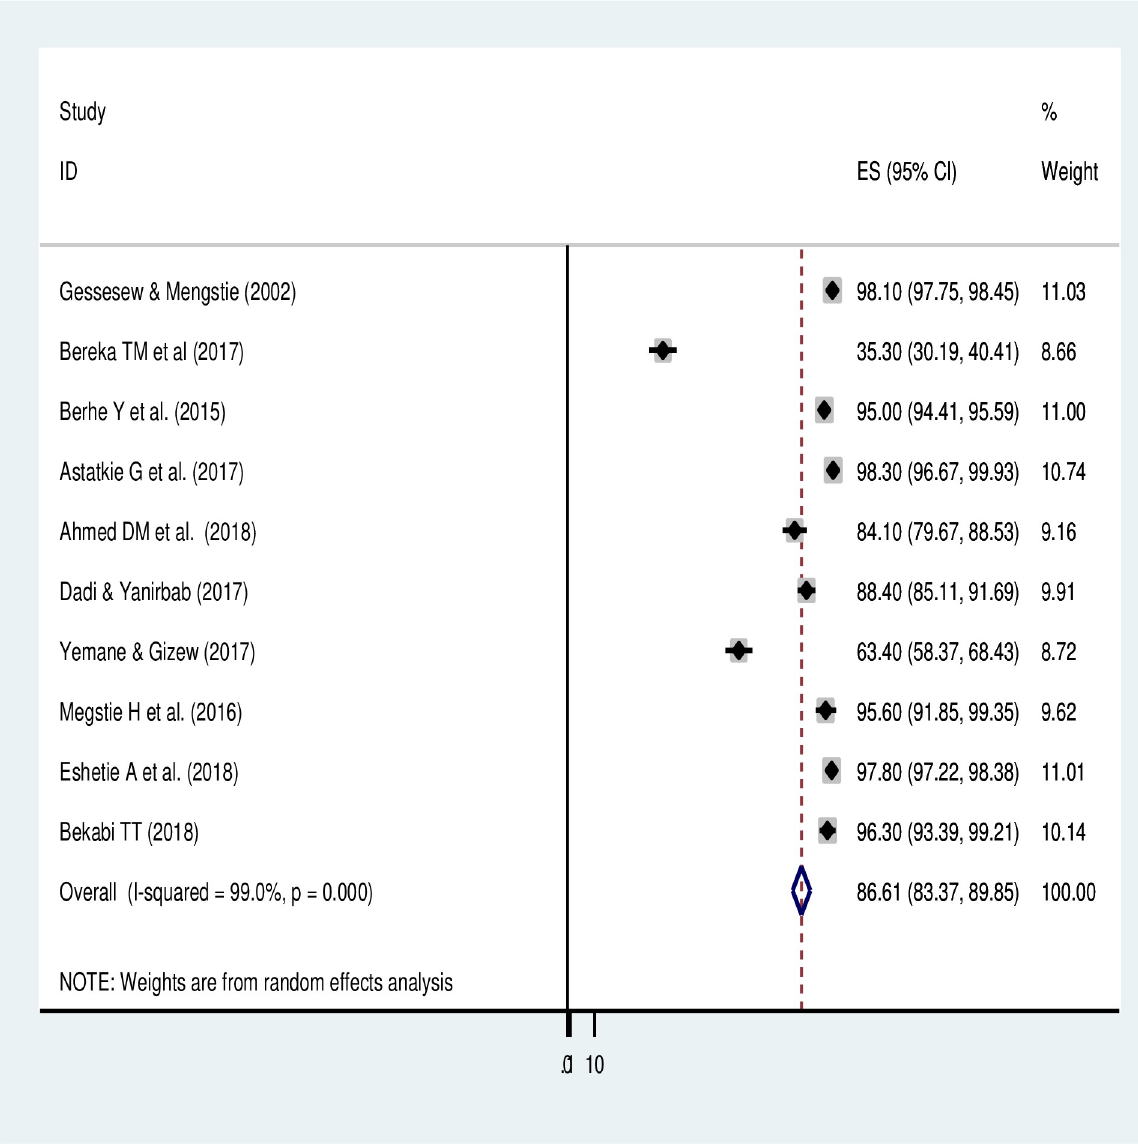
Fig 3. Forest plot on prevalence of perinatal death of uterine rupture in Ethiopia.